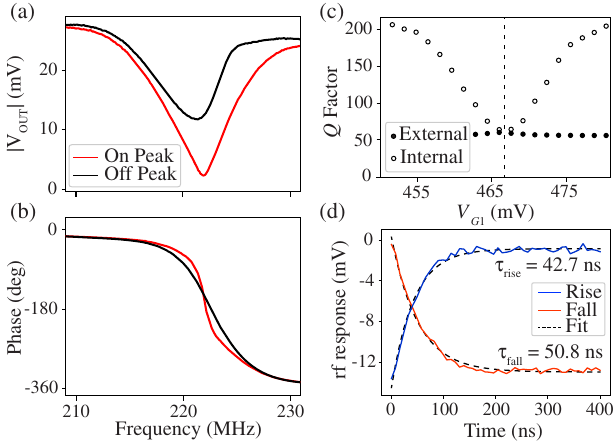
FIG. 5. Characterization of the resonator circuit. Panels (a) and j and phase, respectively, as a (b) show the rf amplitude j V OUT function of the rf-input frequency used showing a clear resonance around 223 MHz. The resonance changes significantly between cases in (black) and out (red) of Coulomb blockade. (c) Internal (empty circles) and external (filled circles) quality factors as a function of gate voltage across a Coulomb peak. The external quality factor is constant while the internal quality factor changes by a factor of 4. Dotted lines show when internal and external quality factors are approximately equal, corresponding to the impedance matching condition. (d) Rising (blue) and falling (red) response of the resonating circuit as it is pulsed in and out of Coulomb blockade by a 50 kHz square pulse on a nearby electrical control gate. The responses are fitted to exponential ¼ 42 . 7 ns and fall decays (black dash) to extract a rise time T rise ¼ 50 . 8 ns, reflecting the change in Q time T fall